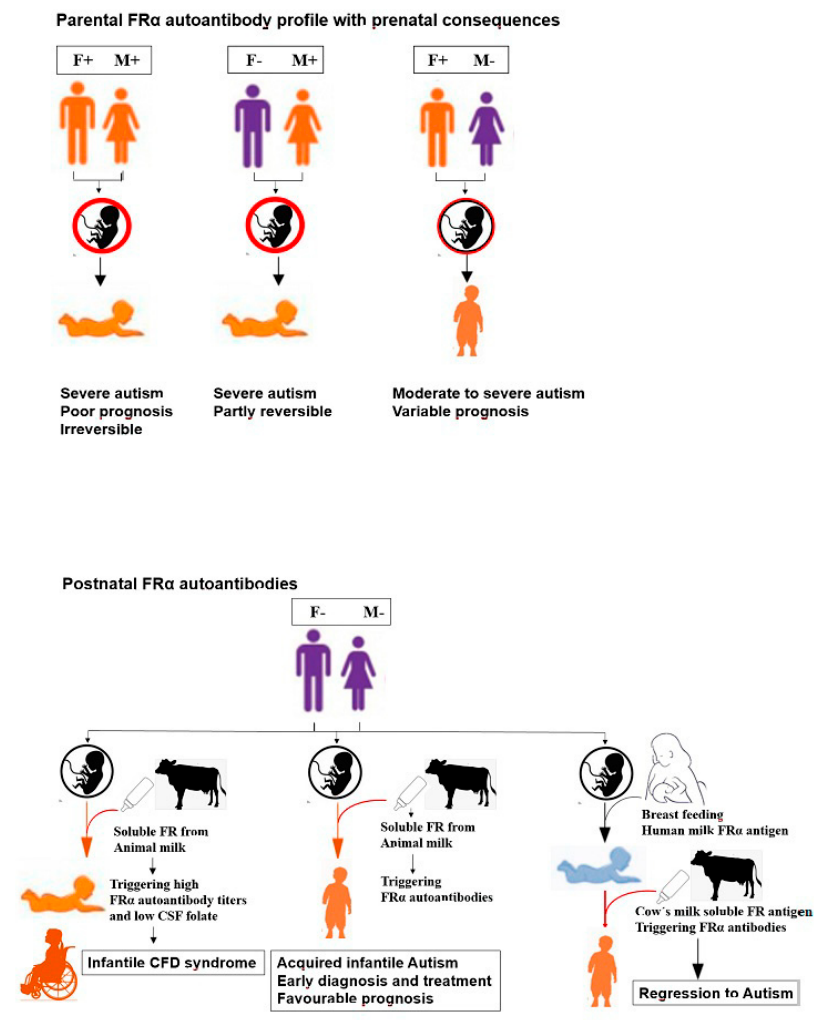
Figure 4. The significance of parental antibody status on developmental outcomes in offspring (top panel) and postnatal antibody development in offspring (bottom